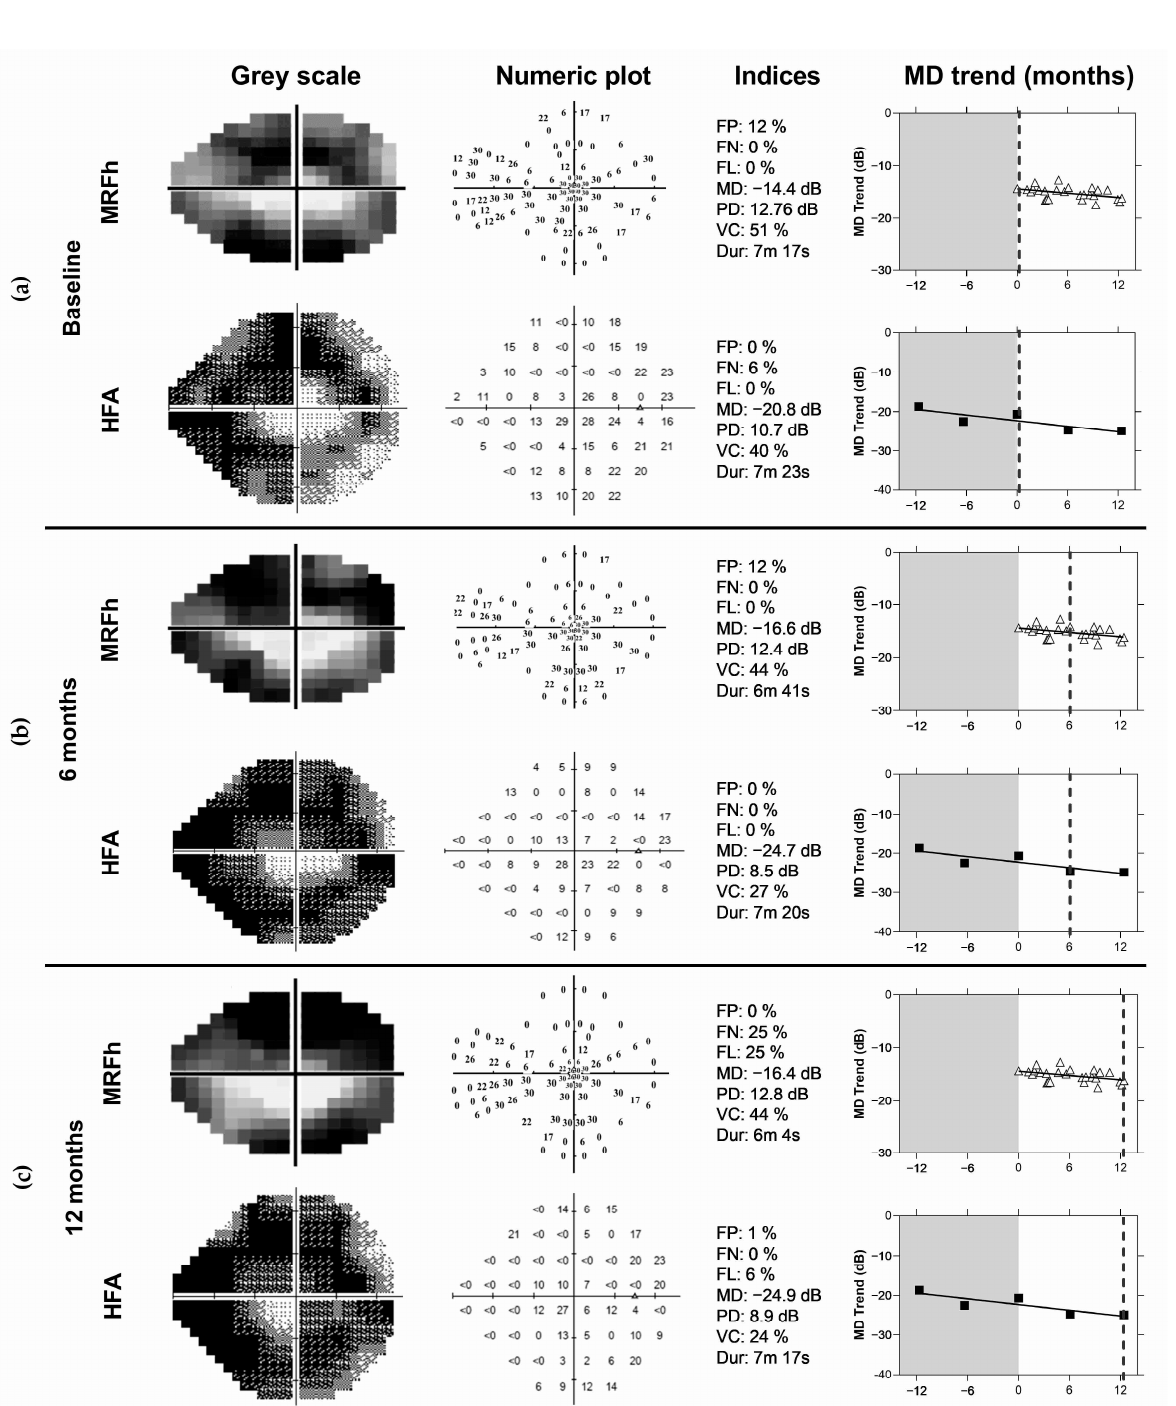
Figure 6. Typical outcome returned after 12 months of the VFTM by a 58 year old with glaucoma progression identified by clinical methods. The MRFh and HFA results are shown at ( a ) baseline, ( b ) 6 months and ( c ) 12 months. Right panels show the mean deviation trend (MD, dB) over 12 months for MRFh (filled triangles) and HFA (filled squares). x -Axis labels indicate months. The grey shaded area of the MD trend represents the period prior to VFTM where 2 reliable HFA fields were obtained as a baseline for GPA analysis (5 reliable results in total). The dotted line indicates the timepoint for a representative VFTM result. FP: False positive rate; FN: false negative rate; FL: fixation loss; MD: mean deviation; PD: pattern deviation; VFI: visual field index; VC: visual capacity; Dur: test duration.